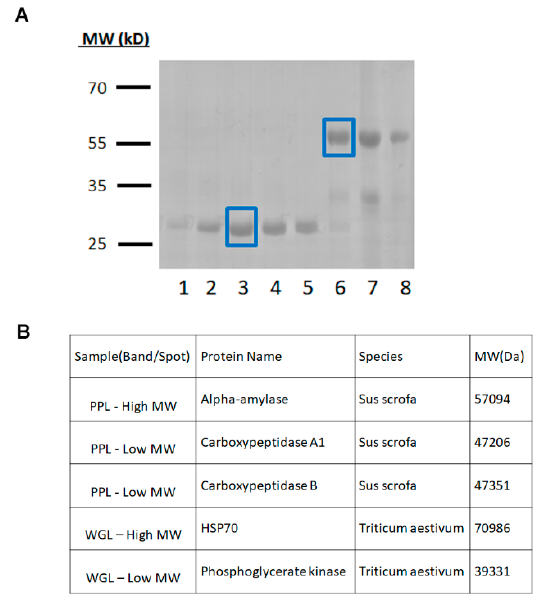
Figure 5. Identification of components of lipase L1 (Porcine Pancreatic Lipase) and L3 (Wheat Germ Lipase) preparations. ( A ) PPL lipase preparation was purified using size exclusion chromatography.